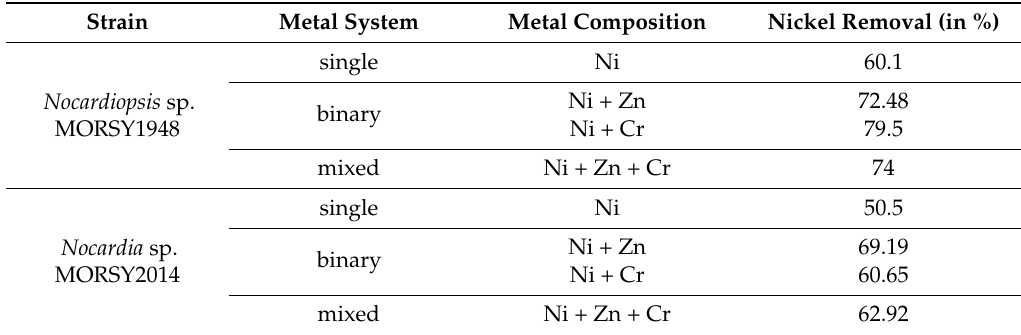
Table 2. Summary of El-Gendy and El-Bondkly nickel removal experiment using Nocardiopsis sp. MORSY1948 and Nocardia sp. MORSY2014 actinomycetes biomass. Strain Metal System Metal Composition Nocardiopsis